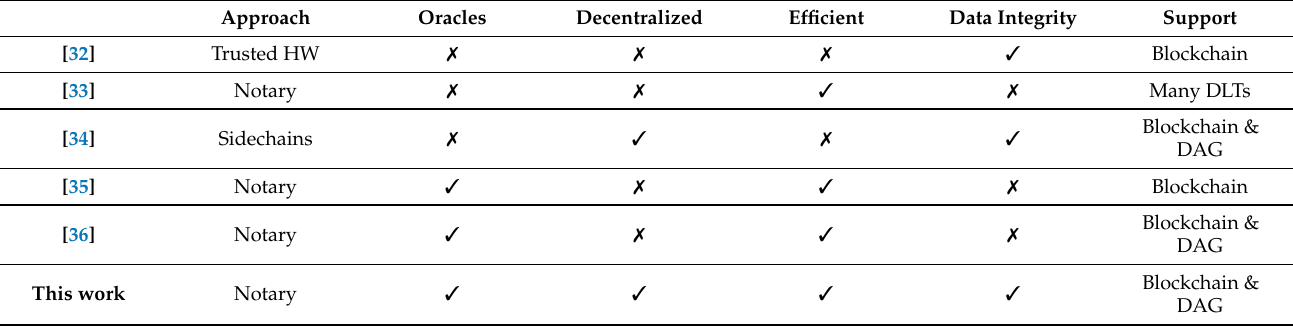
Table 1. Related works comparison